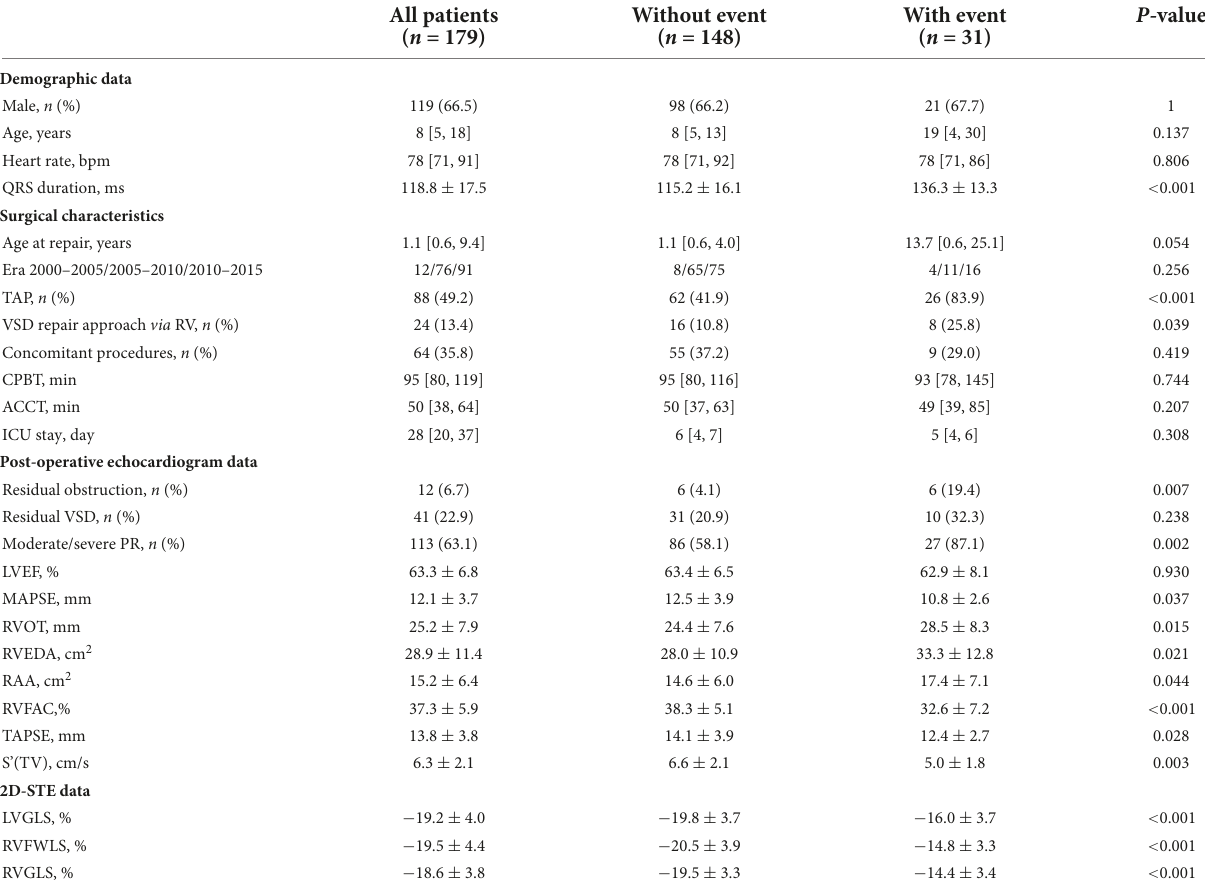
TABLE 2 Post-operative baseline characteristics of r-TOF patient with and without adverse event.